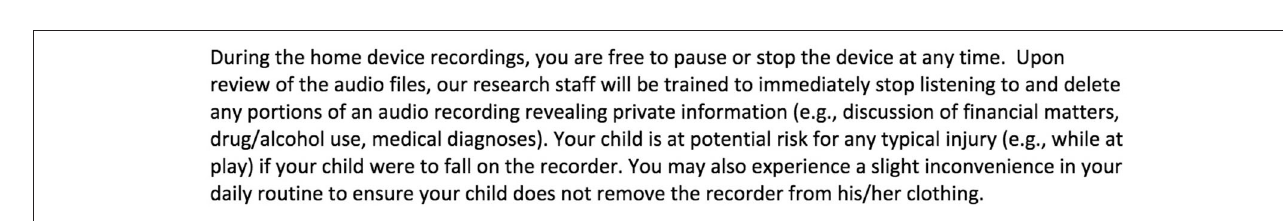
FIGURE 3 | Example of a paragraph in the original IRB-approved consent form.